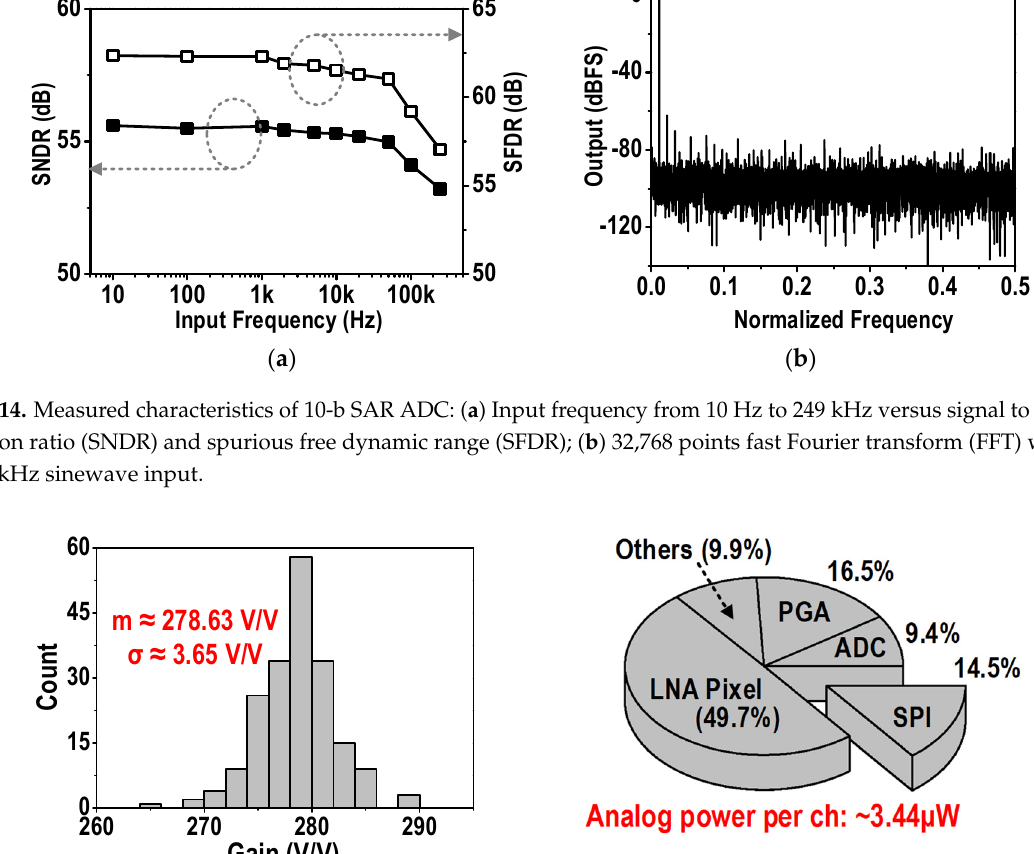
Figure 14. Measured characteristics of 10-b SAR ADC: ( a ) Input frequency from 10 Hz to 249 kHz versus signal to noise and distortion ratio (SNDR) and spurious free dynamic range (SFDR); ( b ) 32,768 points fast Fourier transform (FFT) with a full scale 5 kHz sinewave input. Figure 15. Measured characteristics analog frontend: ( a ) Gain distribution of 12 different samples; ( b ) Percentile of per channel power consumption.